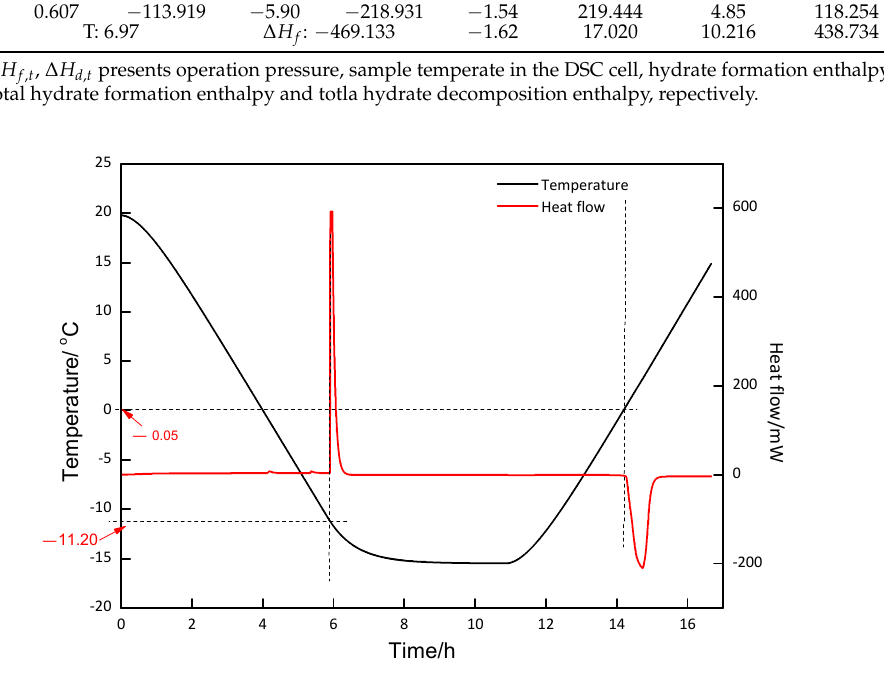
Table 2. The heat flow and temperature of the peaks corresponding to hydrate formation and dissociation under different experimental runs.